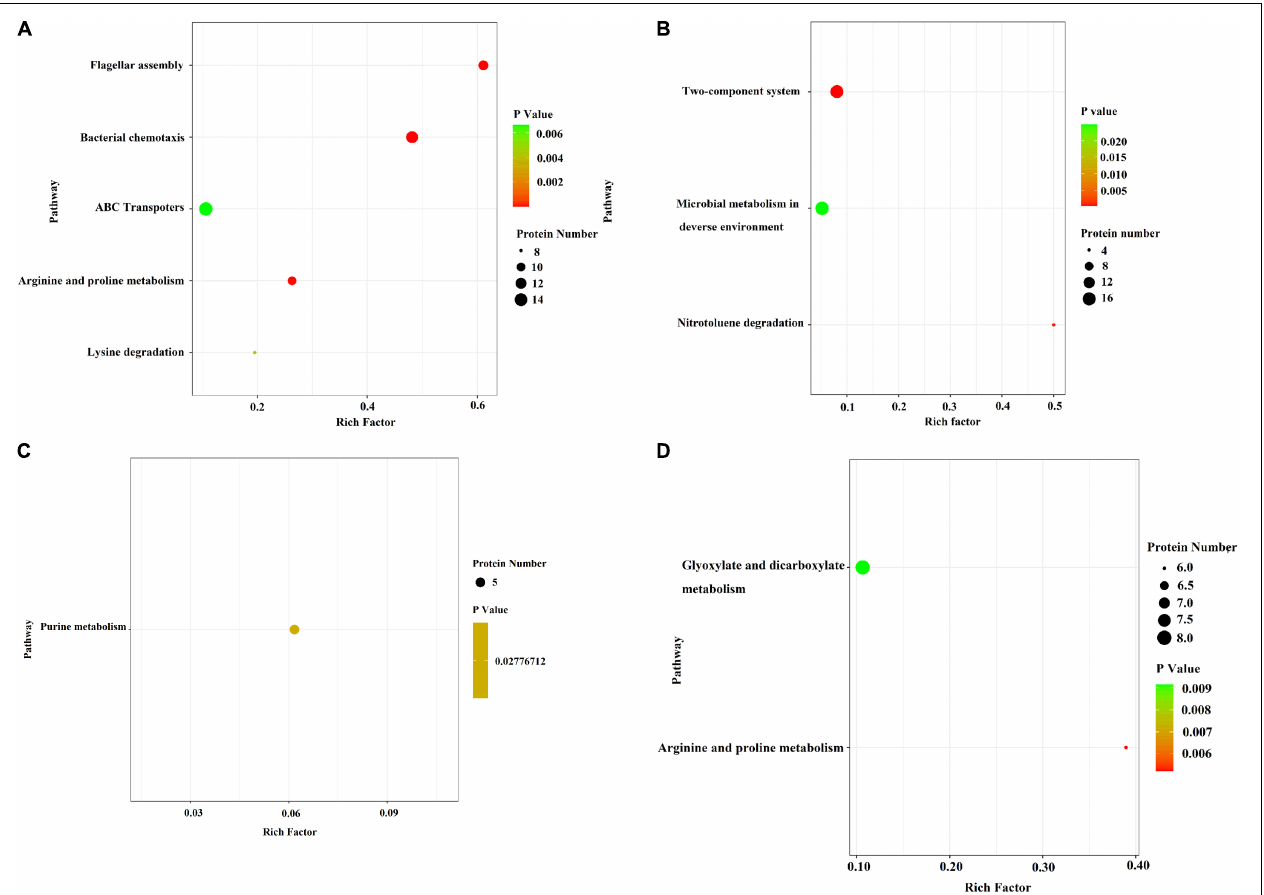
FIGURE 5 | Bubble chart of differentially expressed protein-related KEGG enrichment pathways in the E. coli JW4073(S)/ E. coli K12(K) group and E. coli JW4074(R)/ E. coli K12(K) group. (A,B) Represent differentially expressed protein enrichment pathways in the E. coli JW4073(S)/ E. coli K12(K) group; (C,D) represent differentially expressed protein enrichment pathways in the E. coli JW4074(R)/ E. coli K12(K) group, P <